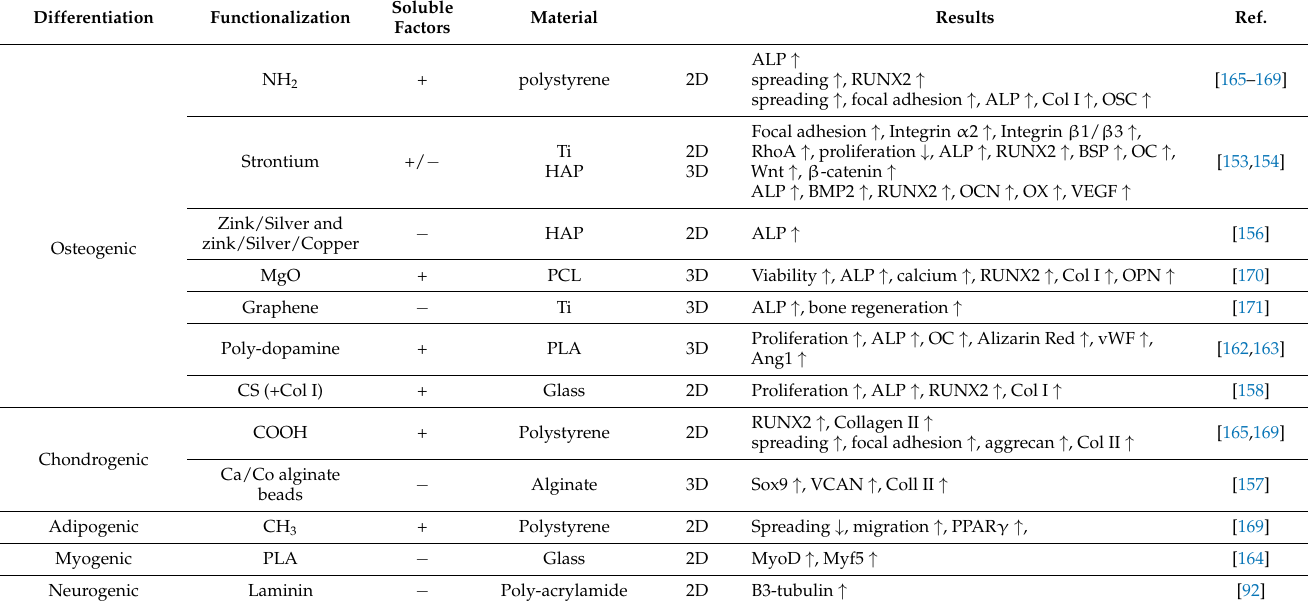
Table 5. Overview of the influence of (bio)chemical functionalization on ASCs. (HAP: hydroxyapatite, PCL: poly caprolactone, PLA: polylactide, CS: chondroitin